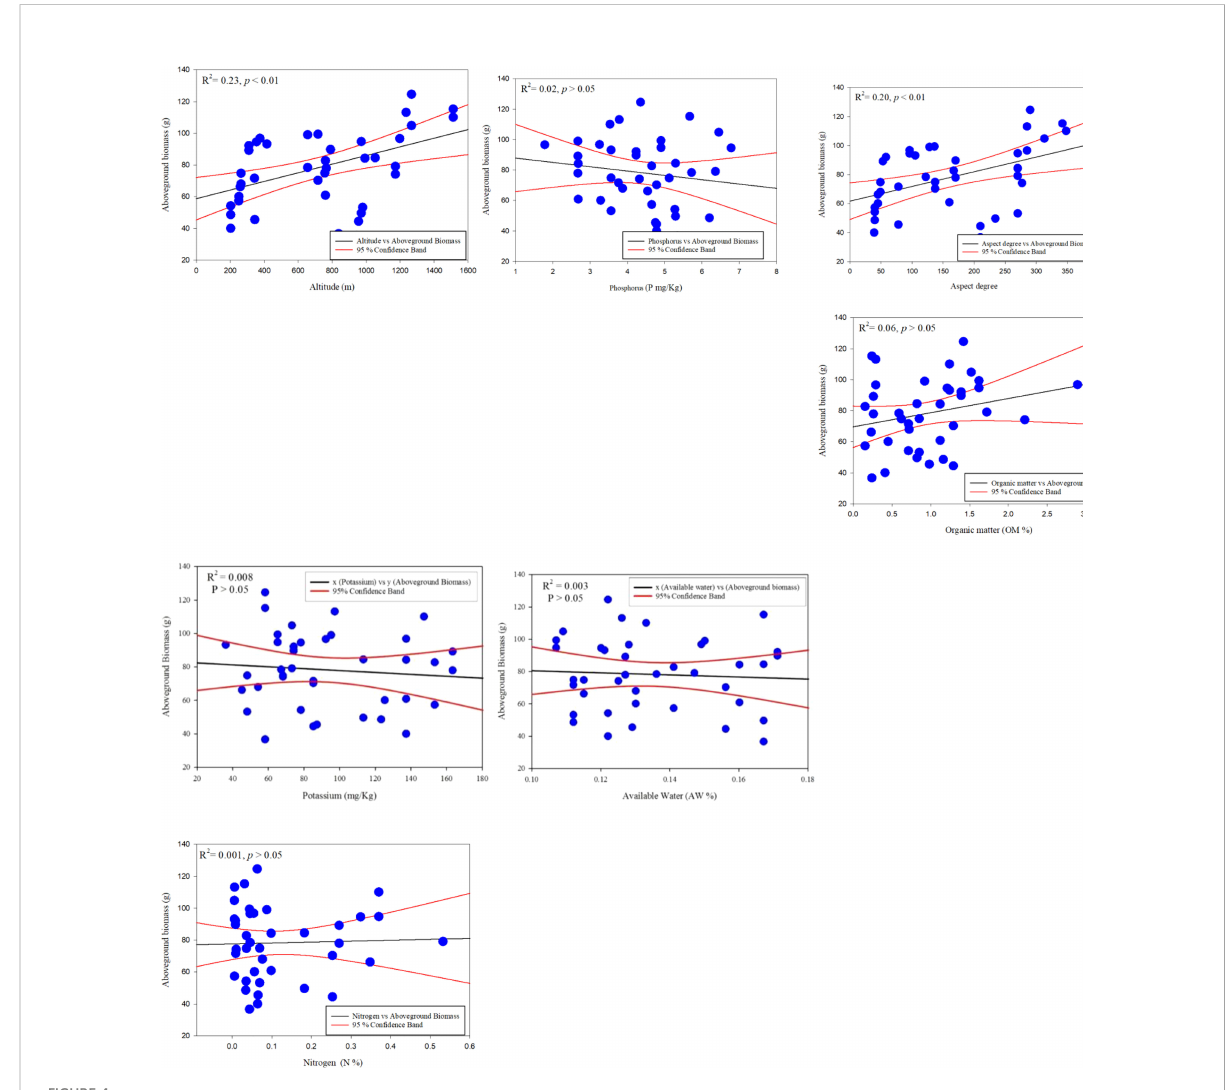
FIGURE 4 Linear regression model for C. procera biomass with environmental